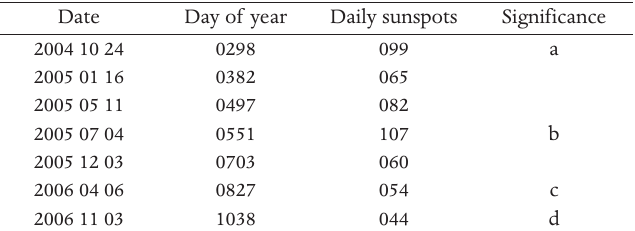
Table 2. Sunspot numbers associated with the solar activity.